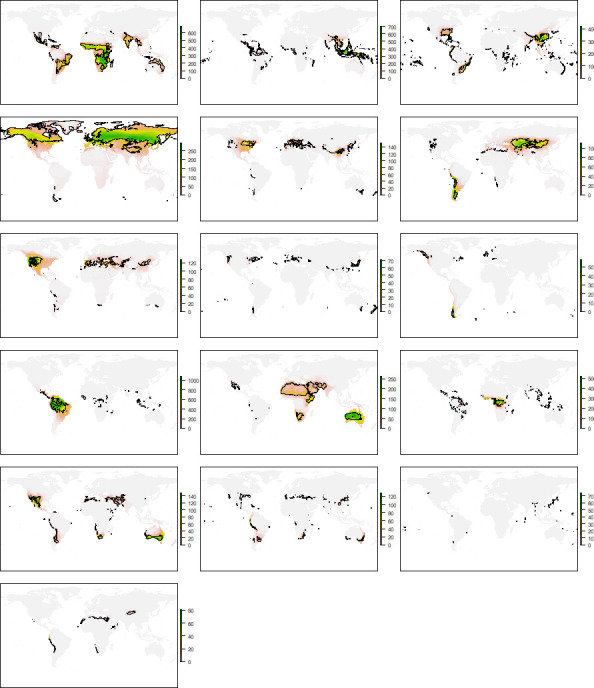
Distribution of the climatic conditions (black line) and the species (colored richness values) belonging to the same niche domains of tetrapods.